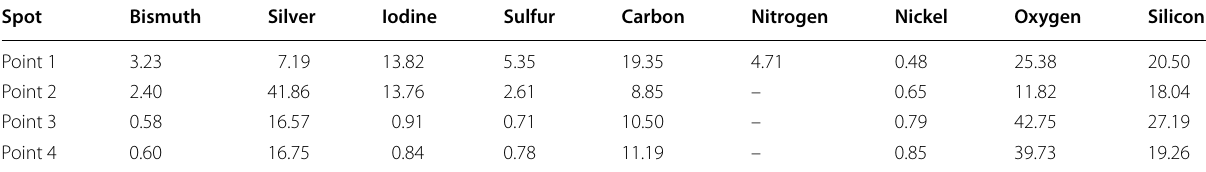
Table 11 Elemental distribution (atomic %) of the individual elements observed on Ag in Fig. 8d Spot